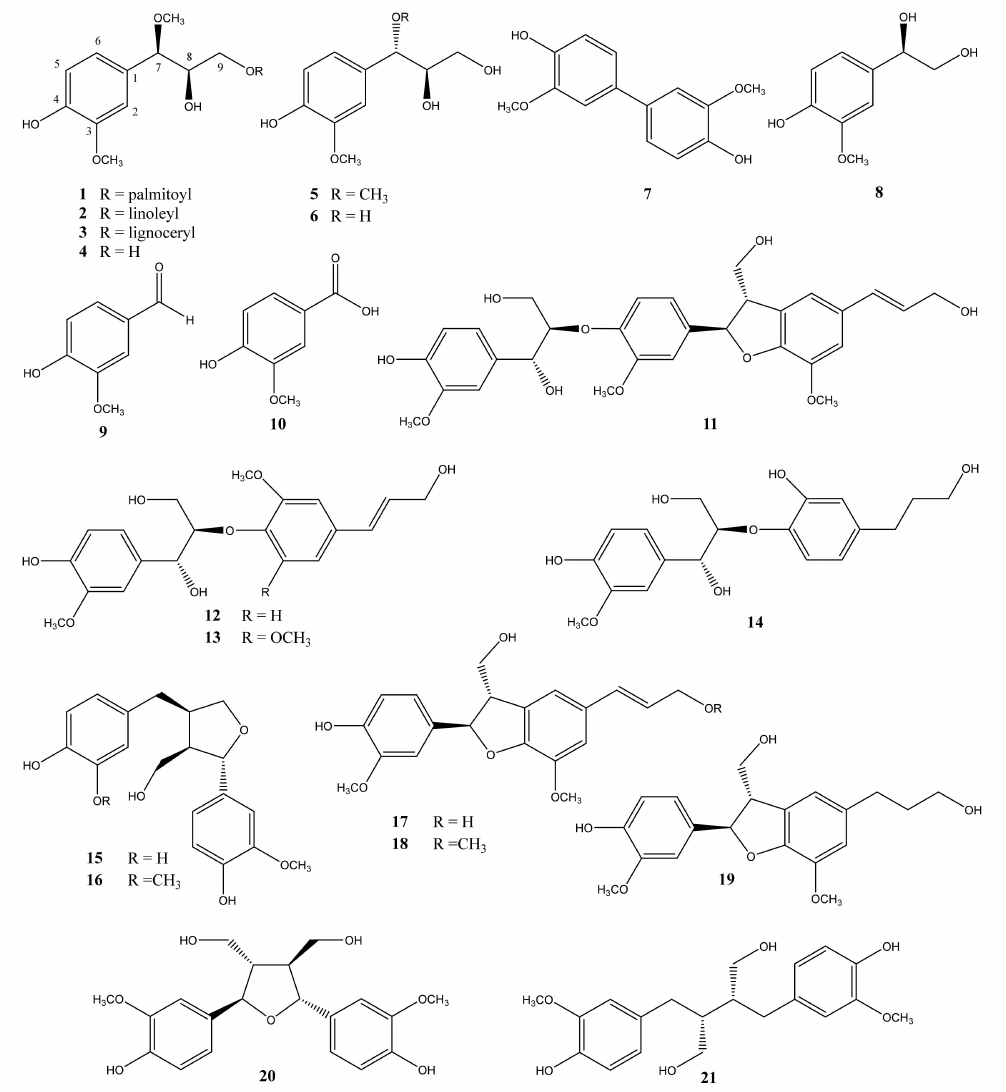
Figure 1. Structures of compounds 1 – 21 from the root of P. grandiflorum